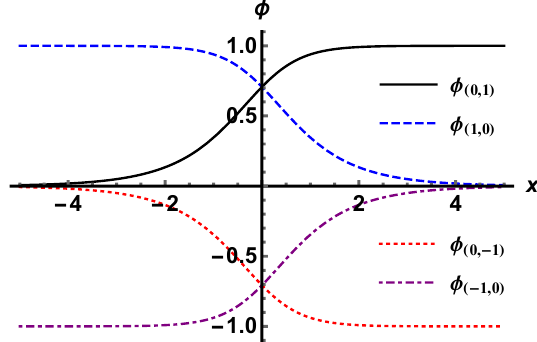
Figure 2. Kinks and antikinks of the (cid:30) 6